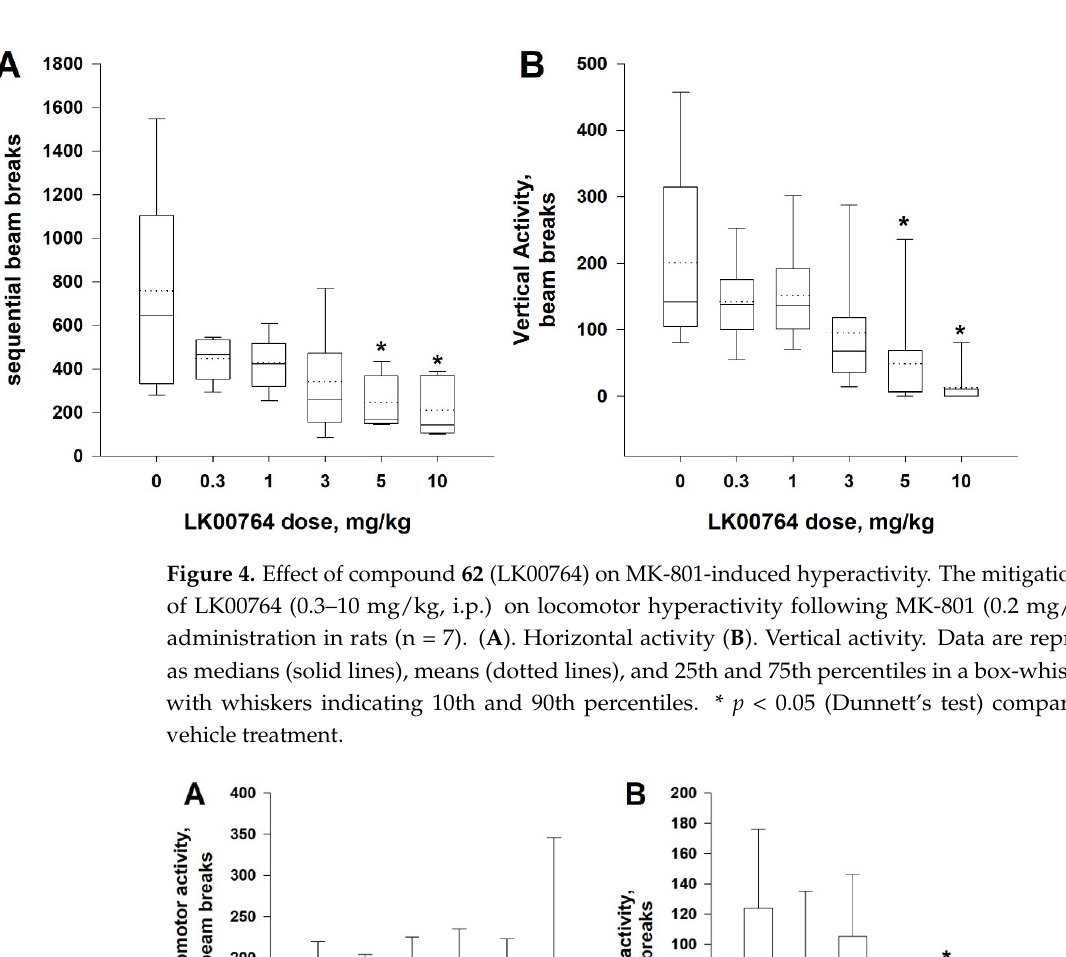
Figure 6. Effect of compound 62 (LK00764) locomotor activity of DAT ‐ KO rats. Administration of compound 62 (LK00764, 1–10 mg/kg, i.p.) decreased both horizontal ( A ) and vertical activity ( B ) of DAT ‐ KO rats. Data are represented as medians (solid lines), means (dotted lines), and 25 th and 75 th percentiles in a box ‐ whisker plot, with whiskers indicating 10 th and 90 th percentiles. * p < 0.05 (Dun ‐ nett’s test) compared to vehicle ‐ treated rats (n = 9 per group).